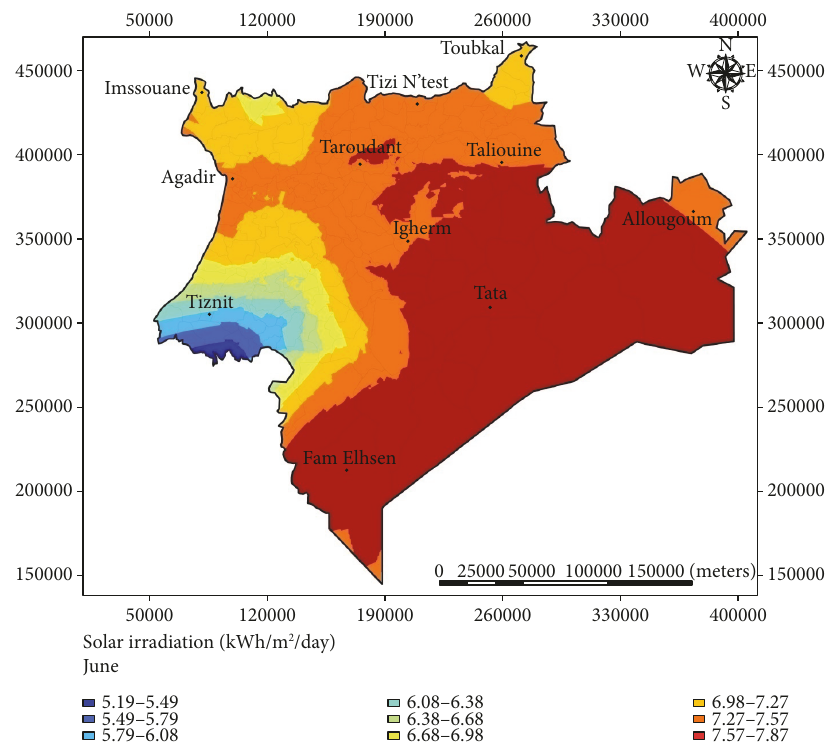
Figure 14: Solar energy potential map of the Souss-Massa area for the month of June as estimated by the ANN and designed with the Kriging interpolation